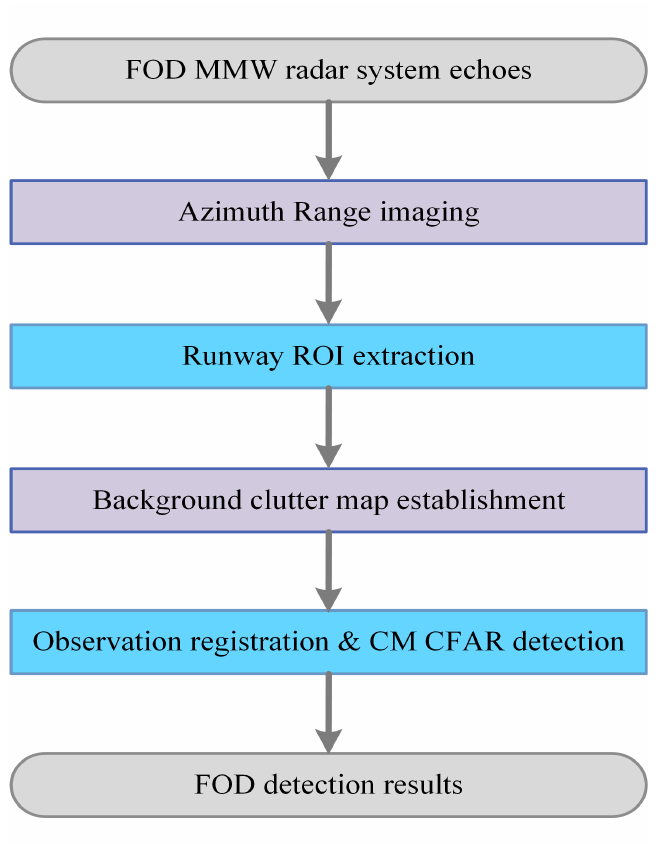
Figure 2. The processing flowchart of our automatic detection for FOD MMW